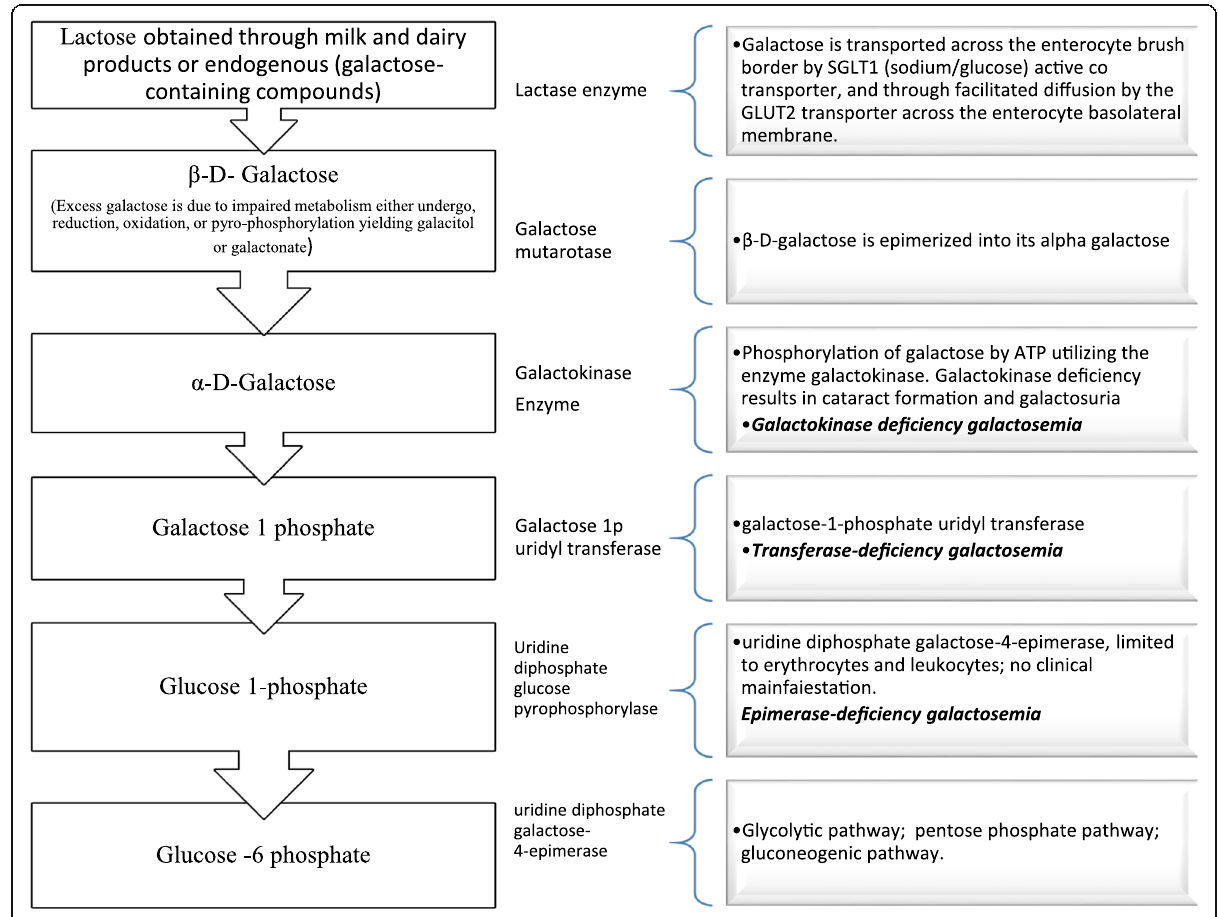
Fig. 2 Galactose metabolism and the effect of enzyme defect on its